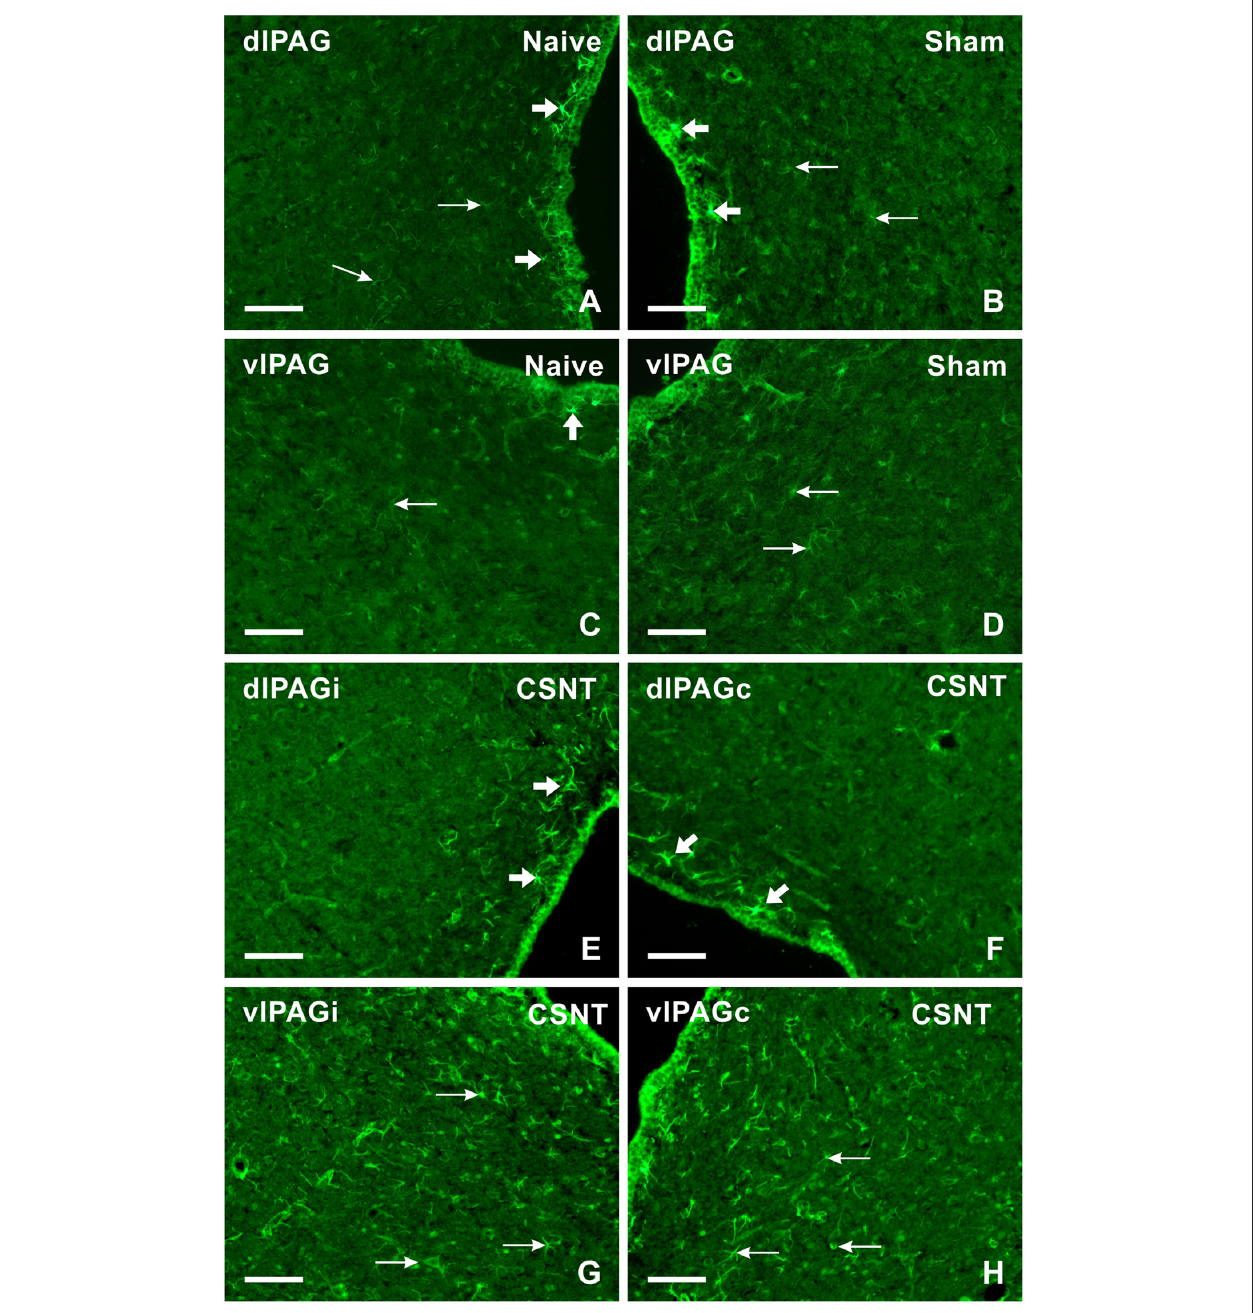
FIGURE 6 | Representative sections showing immunofluorescence staining for CCL2 in dlPAG and vlPAG of naïve (A,C) , sham- (B,D) and CSNT-operated (E–H) rats. Weak CCL2 immunofluorescence was observed in the cells of both dlPAG and vlPAG from naïve and sham-operated controls (arrows in A–D ). Only some cells located close to the ependymal layer displayed intense CCL2 immunostaining (broad arrows in A–D ). Sciatic nerve injury for 3 weeks induced increased CCL2 immunofluorescence intensity in the cells (arrows) mainly in vlPAG of both ipsilateral (vlPAGi) and contralateral (vlPAGc) sides (G,H) . Sections through dlPAG of the same animal (E,F) displayed distinct CCL2 immunofluorescence in a larger number of cells close to the ependymal layer (broad arrows) compared to naïve and sham-operated animals. Scale bars = 80 µ m.